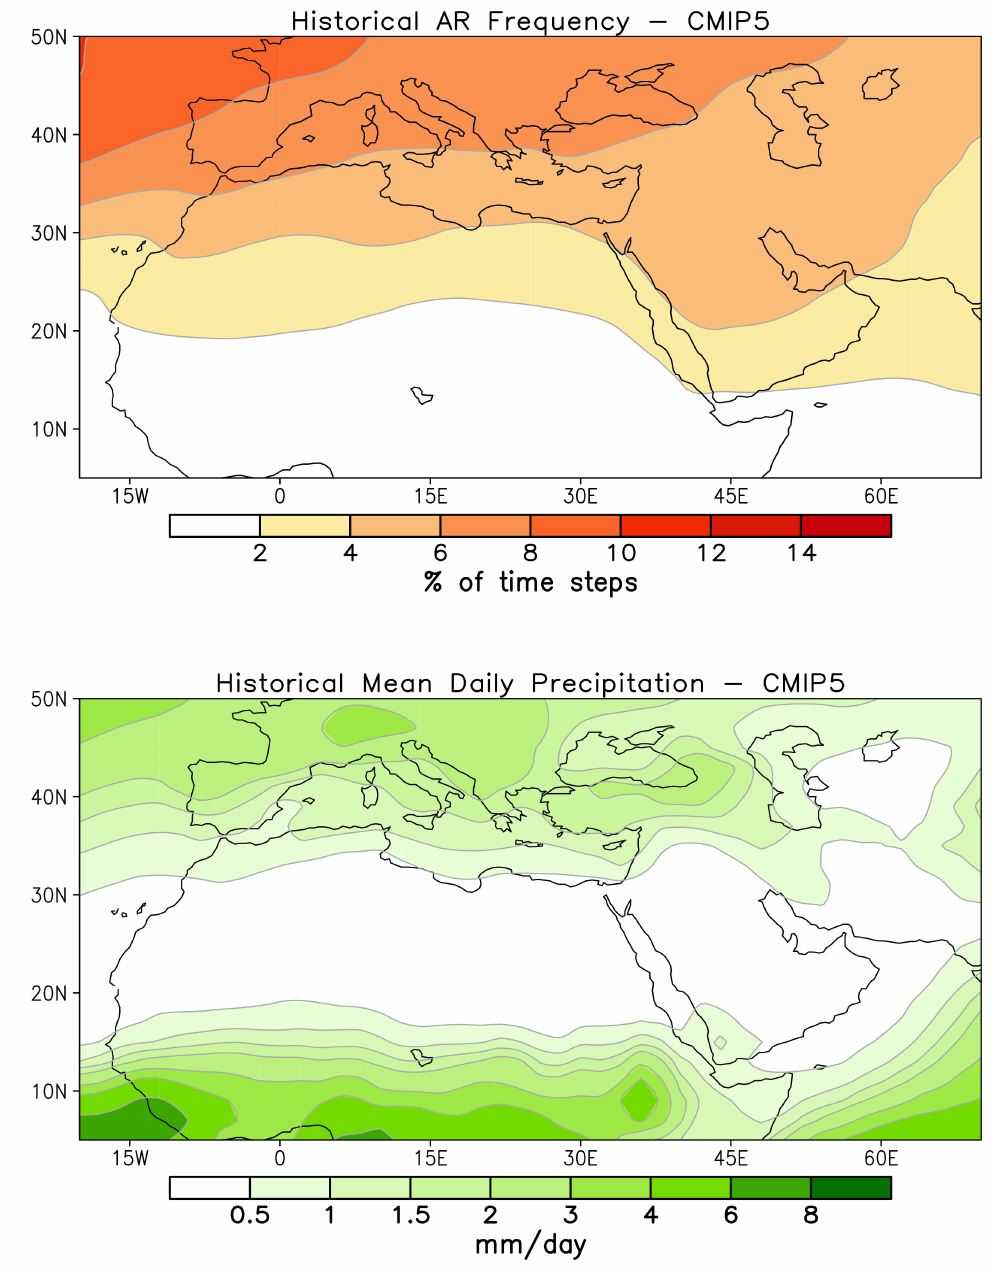
Figure 6. ( Top ) Historical AR frequency (% of timesteps) for the MENA region, as represented by CMIP5 models. Similar to Figure 4a, the top panel of this figure represents the annual historical AR frequency, but shown here for CMIP5 models. ( Bottom ) Historical mean daily precipitation (mm / day) for the MENA region as represented by CMIP5 models. Similar to Figure 5a, the bottom panel of this figure represents the annual historical mean daily precipitation, but shown here for CMIP5